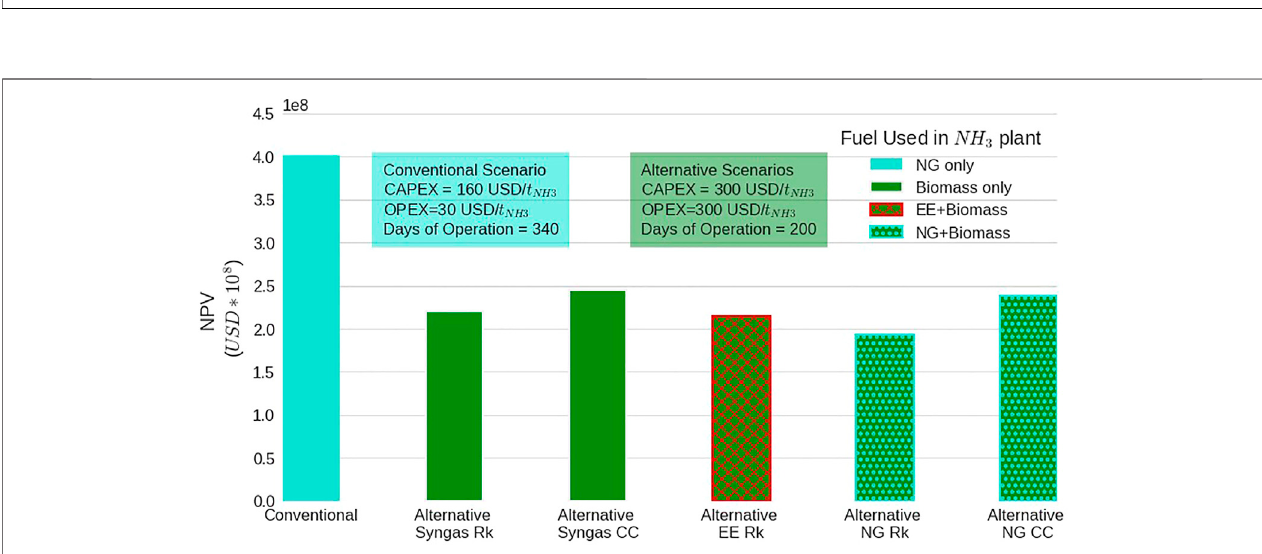
FIGURE8| Unitexergycostsoftheammoniaplantproductsanditspercentageincrementcomparedtotheconventionalscenario, (A) .Othervariablessuchasthe amount of ammonia produced and the CO 2 captured are reported for the alternative ammonia production (B – F) .